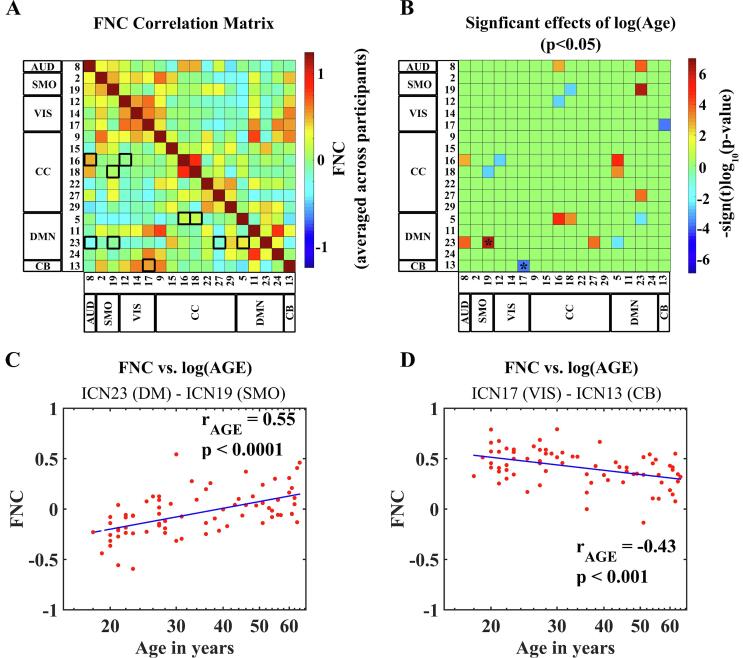
Effects of age on (static) functional network connectivity (FNC) between intrinsic connectivity networks (ICNs). (A): FNC matrix showing the pairwise correlations between ICN TCs (FNC) averaged across all participants. Black squares and rectangles highlight ICN pairs for which significant effects for log(Age) were found. (B): The matrix displays the significance and direction of the effects of age for each pairwise correlation (p < 0.05, FDR-corrected). (C, D): Scatterplots depicting how FNC between pairs of ICN TCs changes for increasing age based on two examples from the significant results displayed in (B): (C) is an example of positive age-related correlation (rAGE) between pairwise FNC and age, based on the pair ICN23 (DM) and ICN19 (SMO). (D) Is an example of negative age-related correlation (rAGE) between pairwise FNC and age, based on the pair ICN17 (VIS) and ICN13 (CB). The examples selected for the scatterplots (C) and (D) are highlighted in the FNC matrix (B) with asterisks. Age is presented in the scatterplots (C) and (D) on a log-scale.